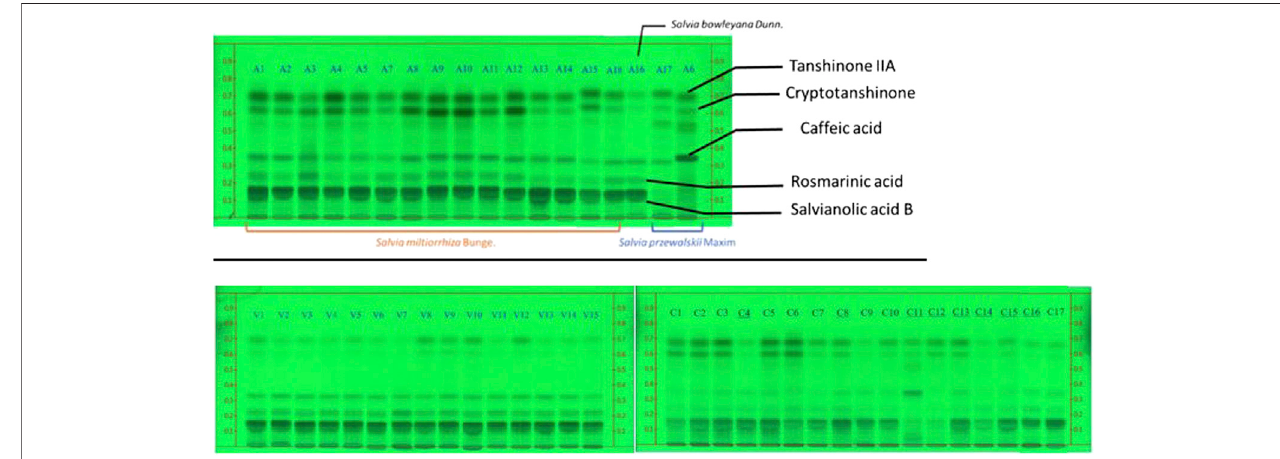
FIGURE 2 | HPTLC results of authenticated samples, Vietnamese samples and Chinese online store samples. The HPTLC is performed under 254 nm developed with solvent system (toluene: chloroform: ethyl acetate: methanol: formic acid (v/v) (cid:1) 2: 3: 4: 0.2: 2). A1 – A18 are authenticated samples including S. miltiorrhiza , S. bowleyana , and S. przewalski . V1 – V15 are Vietnamese samples and C1 – C17 are Chinese online store samples. The samples underlined were sold as grounded powder while others were dried roots.